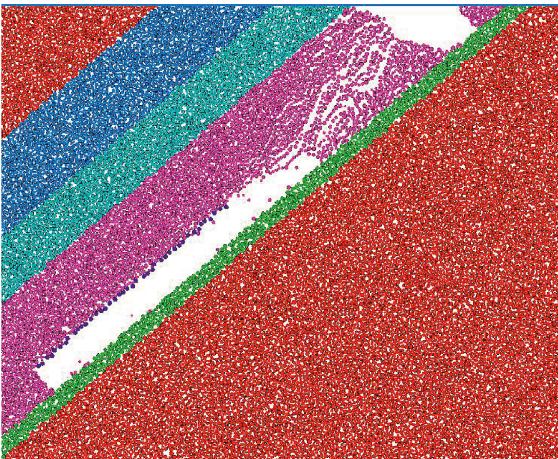
Figure 8: Downward mining and coal caving.